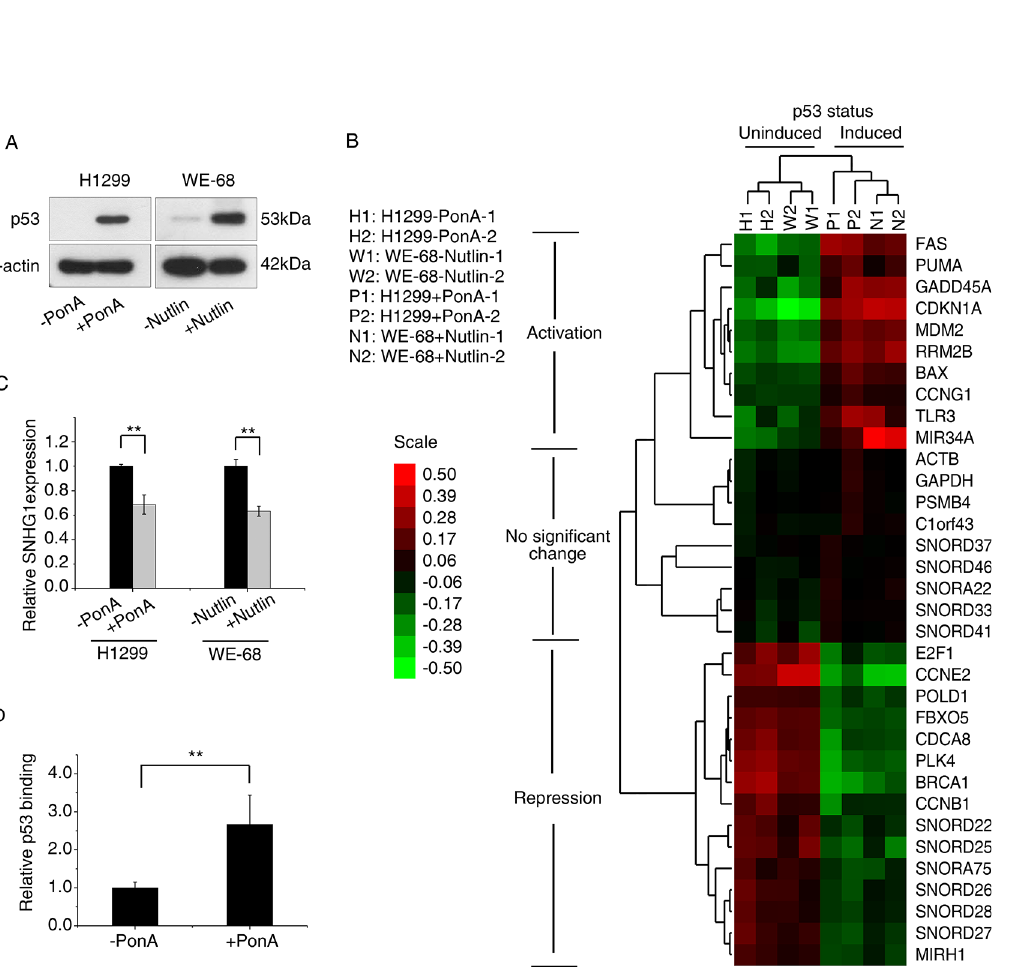
Fig 1. Identification of p53 regulated snoRNAs. (A) Wild type p53-inducible H1299 cells were treated with 2.5 μ g/ml of Ponasterone A (PonA) for 24 hours, and compared with non-induced cells. WE-68 cells were treated with 10nM Nutlin-3a for 16 hours, compared with non-induced cells. Western blots for p53 (and β -actin as a loading control) are shown. (B) Based on microarray profiling, a dendrogram generated by cluster analysis shows the separation of p53 uninduced cells from induced cells, and separation of representative genes activated, repressed or not significantly changed by p53. (C) SNHG1 expression levels were determined by RT-PCR after p53 induction in H1299 and WE-68 cells. (D) ChIP assay, using the anti-p53 antibody DO-1, was performed to determine relative p53 occupancy in p53-induced H1299 cells (+PonA). RT-PCR results show relative p53 occupation at upstream of the SNHG1 promoter, and p53 null H1299 (-PonA) was used as a negative control. ** p < 0.01 versus controls for all